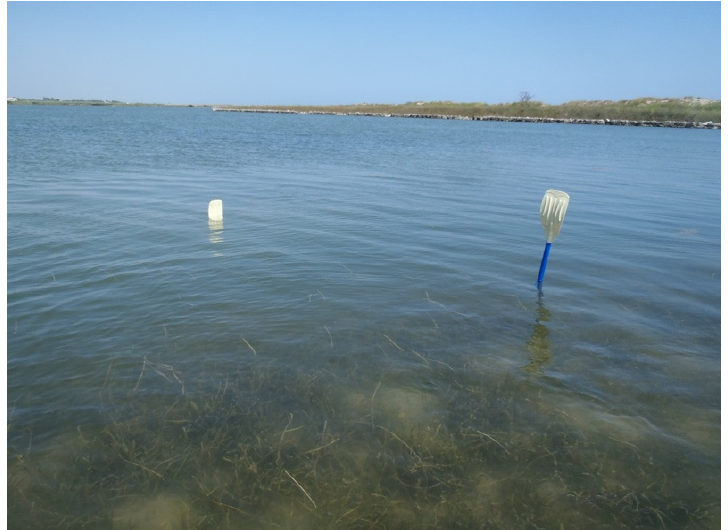
Figure 12. Detail of one of the sinkholes: the oars are located across the sinkhole rim, one outside it, and the other within the depression. The difference in elevation is about 0.7 m.